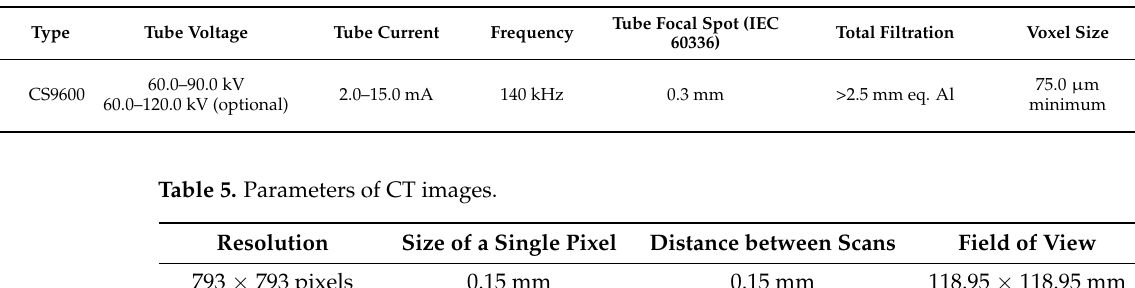
Table 4. CT scanner parameters.